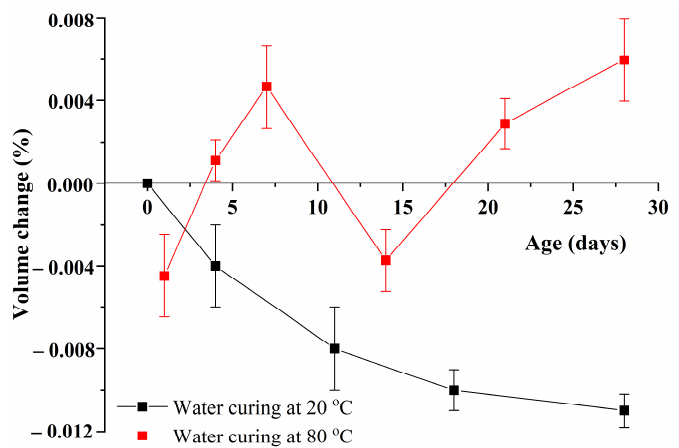
Figure 5. Volume changes of the sample Control 0.41 under water curing at 20 °C and 80